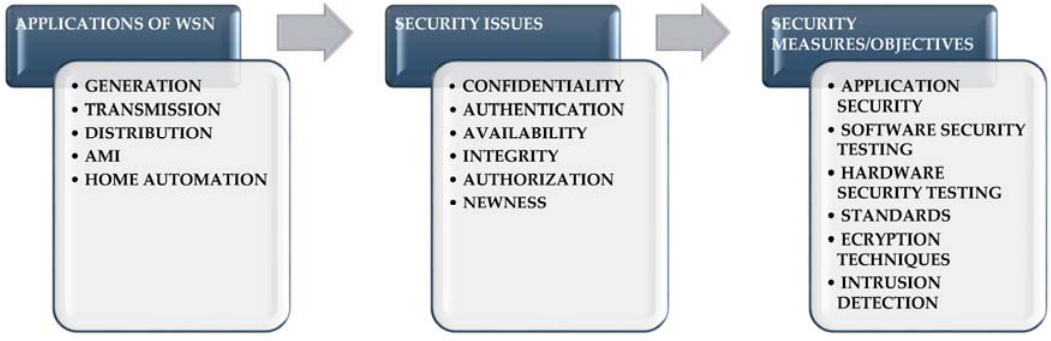
Figure 4. An overview of applications, security issues and security measures for WSN based smart grid architecture.